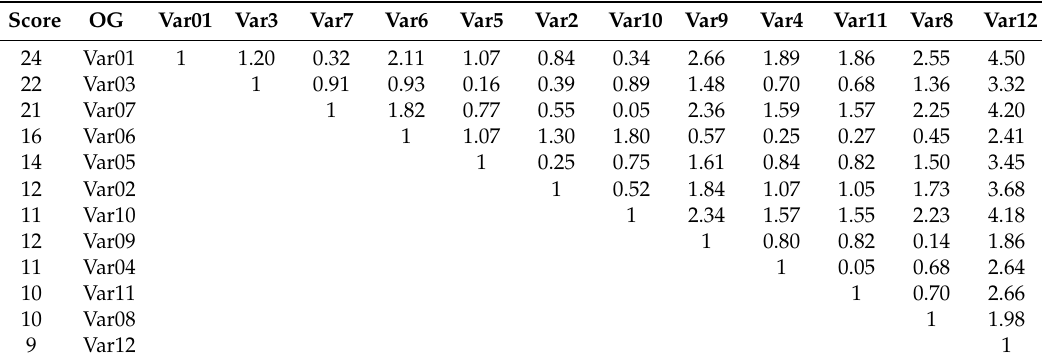
Table 6. Normalization and prioritization of territorial indicators (Analysis Hierarchical Process (AHP)).